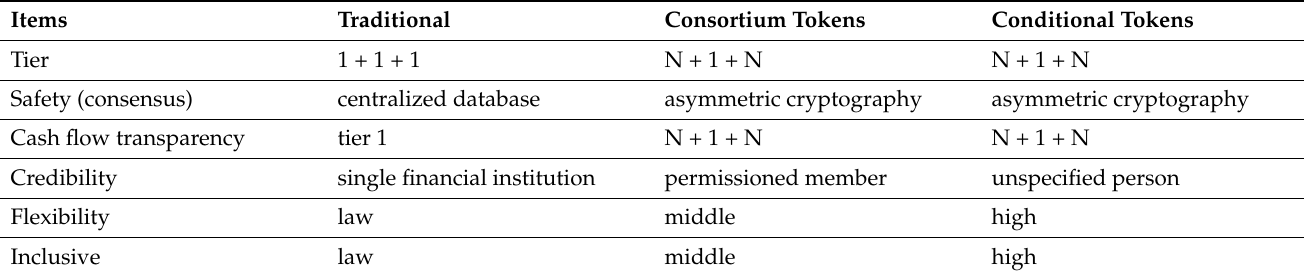
Table 3. Methodology